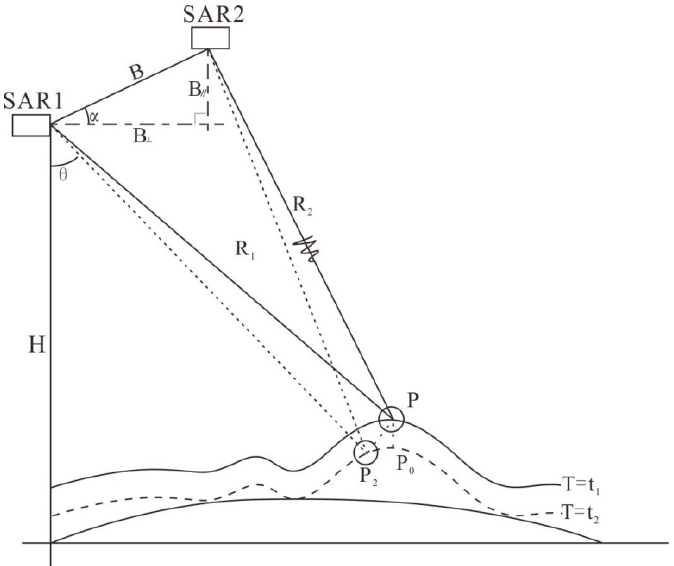
Figure 3. Schematic diagram of the interferometric radar measurement principle (After Usai et al., 2001 [41]).